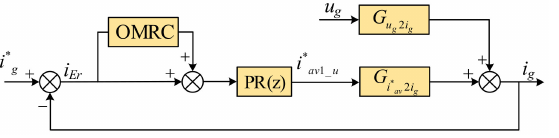
Figure 10. Block diagram of proposed grid-current closed-loop control system.